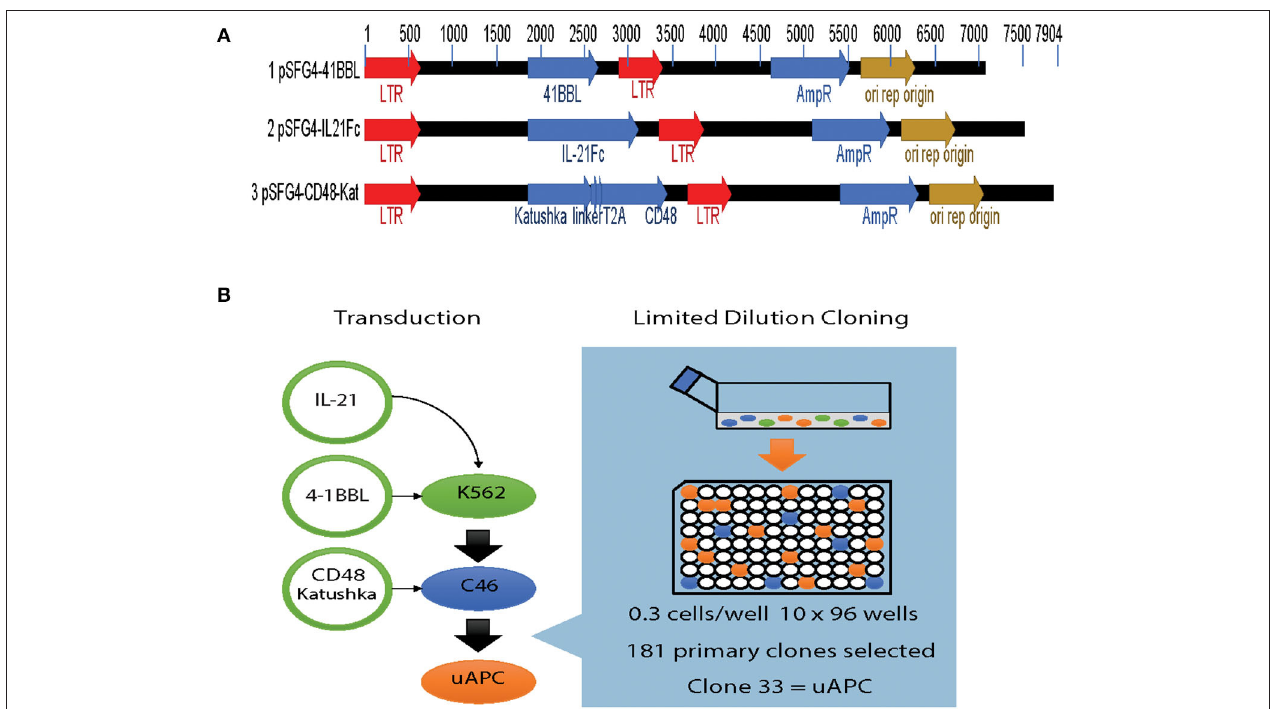
FIGURE 1 | Generation of the K562-based universal antigen presenting cell (uAPC). (A) Retroviral transfer vectors used to introduce the transgenes IL-21, 4-1BBL (CD137L), CD48, and Katushka to enforce their expression in K562. (B) Experimental schema summarizing our strategy to generate uAPC. Transgenes were retrovirally transduced serially into K562 cells, and limiting dilution cloning performed after each transduction to derive uAPC. Clone 46 (C46) is an intermediate clone positive for membrane-bound IL-21 and 4-1BBL. uAPC is positive for membrane-bound IL-21, 4-1BBL, and